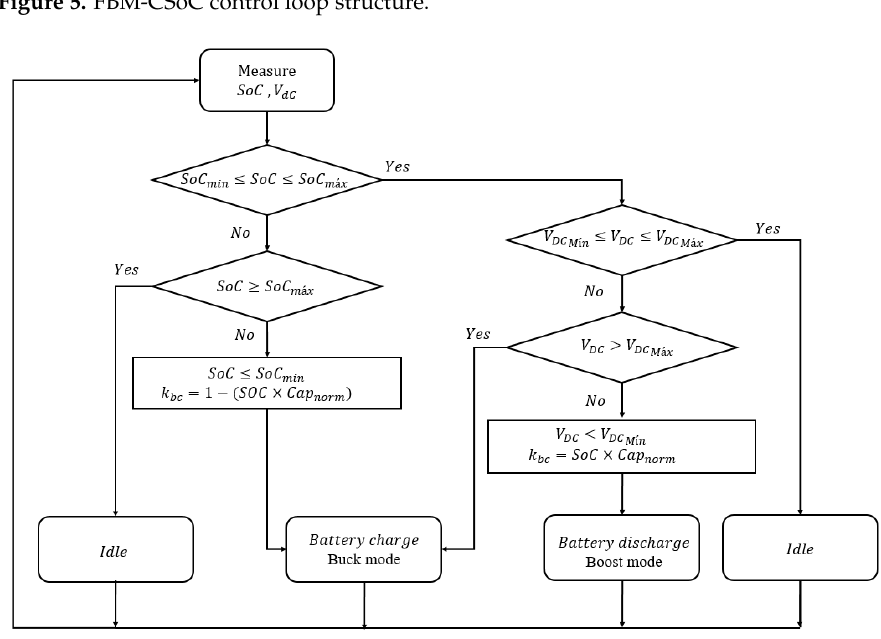
Figure 6. Flowchart of the HESS charge and discharging